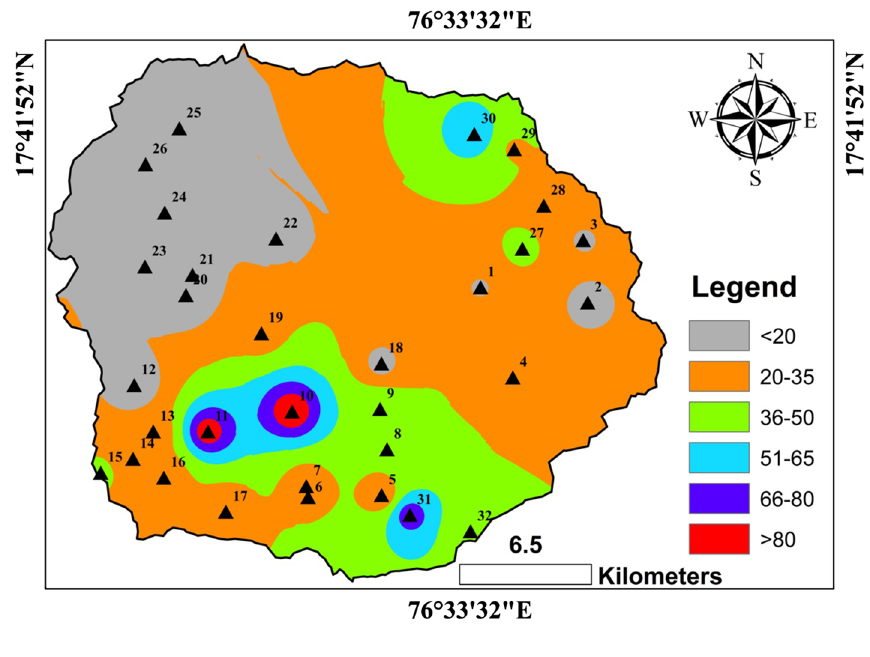
Fig. 28 Geospatial distribution of sulphate (pre-monsoon)